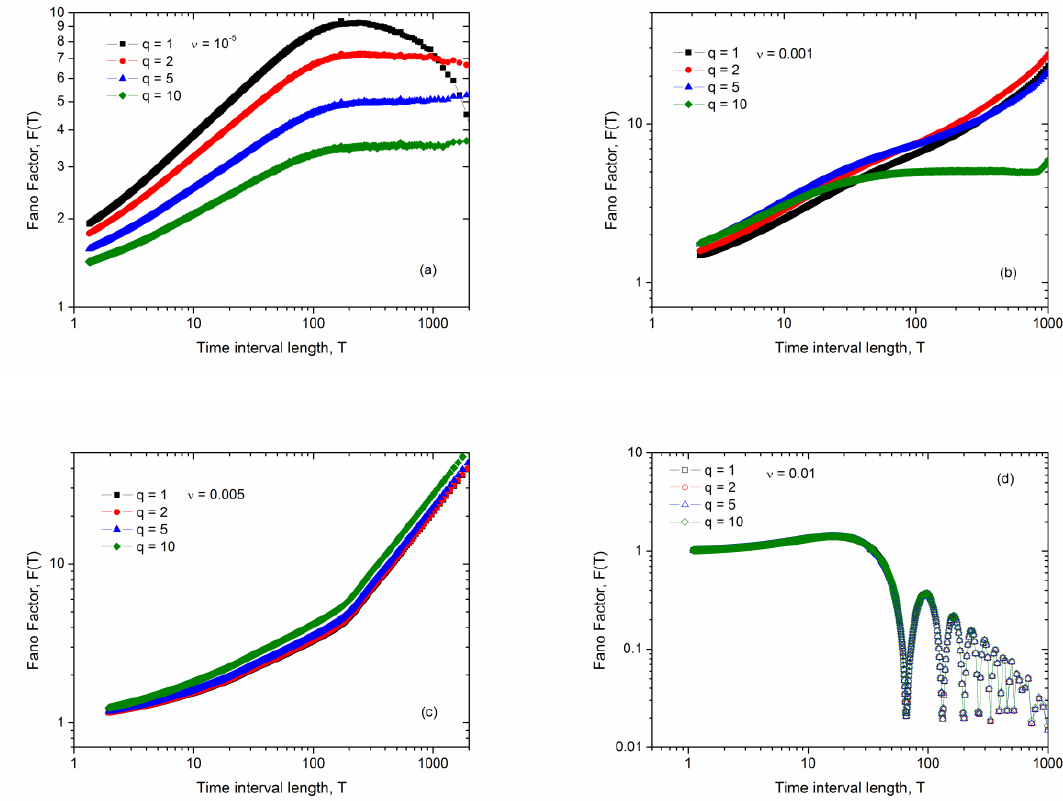
Fig. 5. Fano factor analysis for simulated landslide event series with four thresholds q , and for different values of ν . The behaviour of F(T ) shows fractal organization of landslide events, with power-law exponents ψ > 0 for ν < 0.01 ( a , b and c ) and an uncorrelated regime for ν = 0.01 (d) . The oscillatory behaviour of F(T ) in (d) is a purely numerical effect due to the finite system size: it is shifted to larger time interval lengths T if larger grid sizes are used.